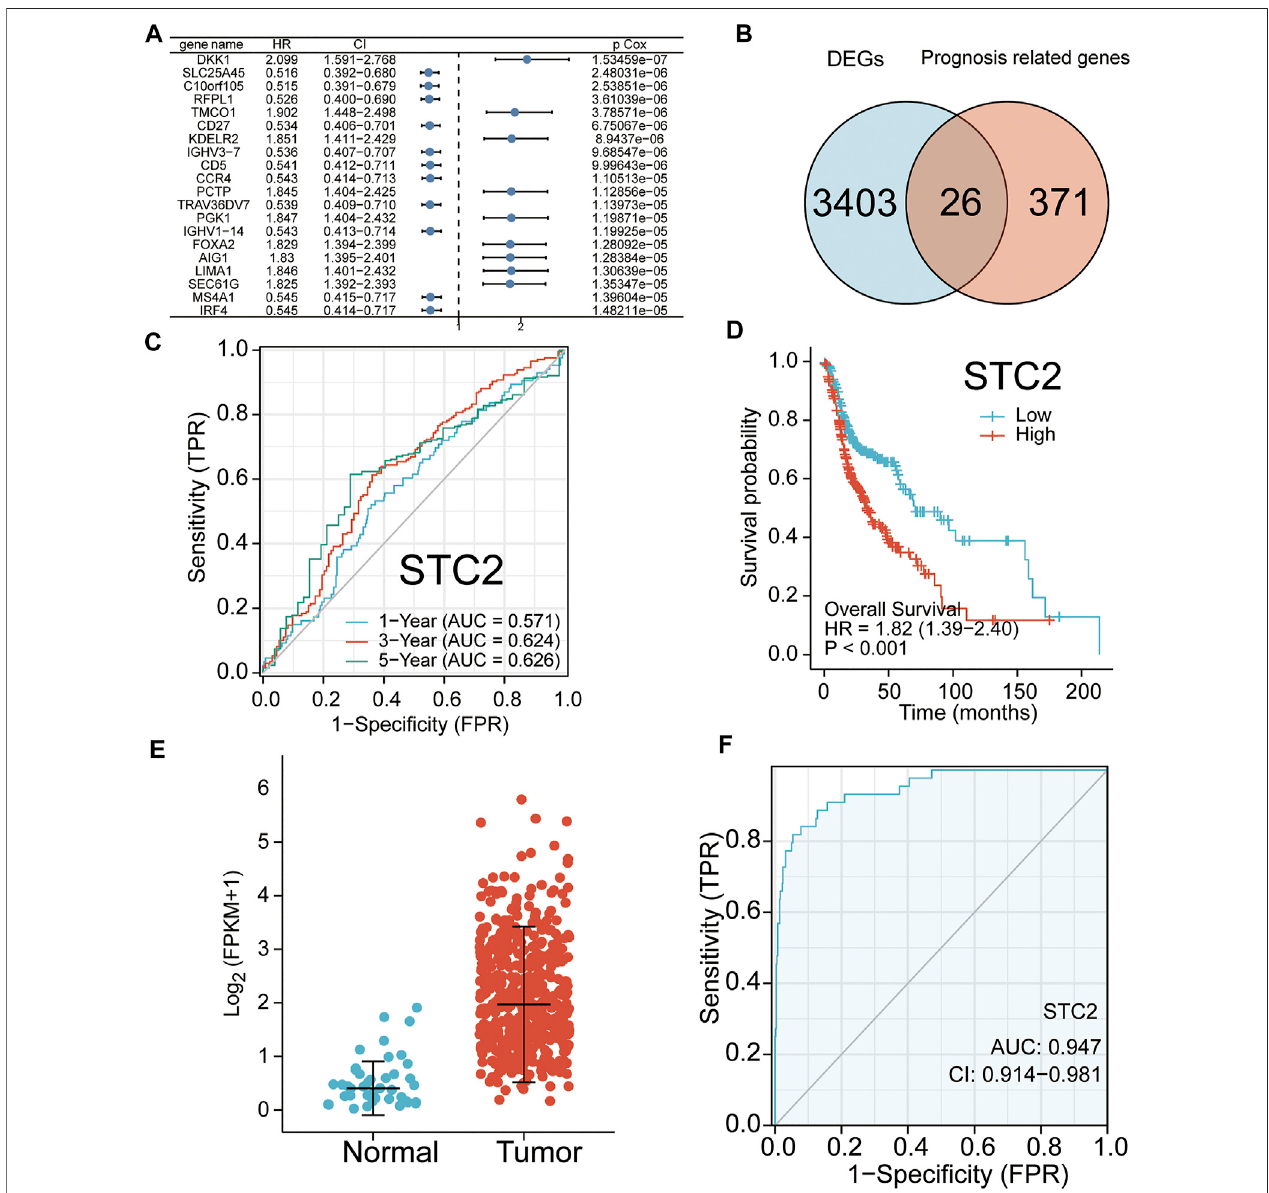
FIGURE 2 | Identi fi ed key genes and their examined prognostic signi fi cance. (A) Top 20 genes with the highest correlation to overall survival (OS) are shown. (B) Crossing the3,429 DEGs with397 prognosis genes. (C) Kaplan – Meier curve ofSTC2. (D) Time-dependent receiver operating characteristics (ROC) curves of STC2 for 1,3,and5 years (E) STC2mRNAlevelsinHNSCCtissues( n =502)andnormaltissues( n =44). (F) Diagnosticsigni fi canceofSTC2inHNSCC.ROCcurveswereplotted and the area under the curve (AUC) of STC2 was 94.7%.